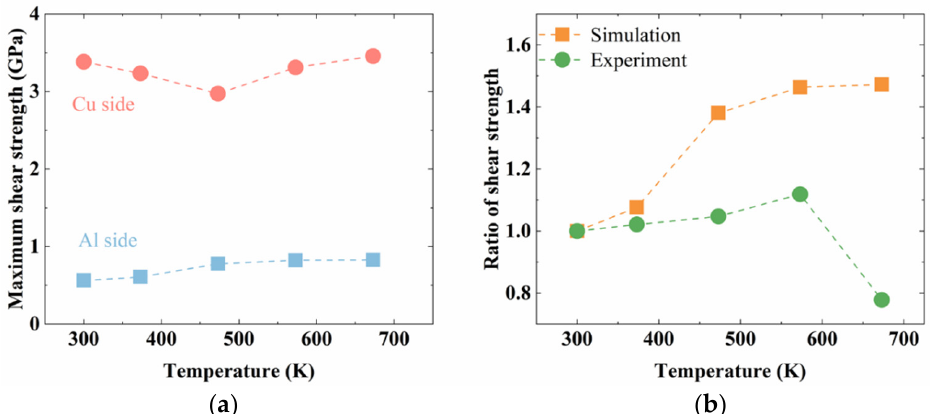
Figure 17. ( a ) The shear strength of Cu–Al 4 Cu 9 structures, and Al 2 Cu–Al structures, and ( b ) the comparison between simulated shear strength ratio (strength of annealed sample over the strength of unannealed sample) and the experimental ones.